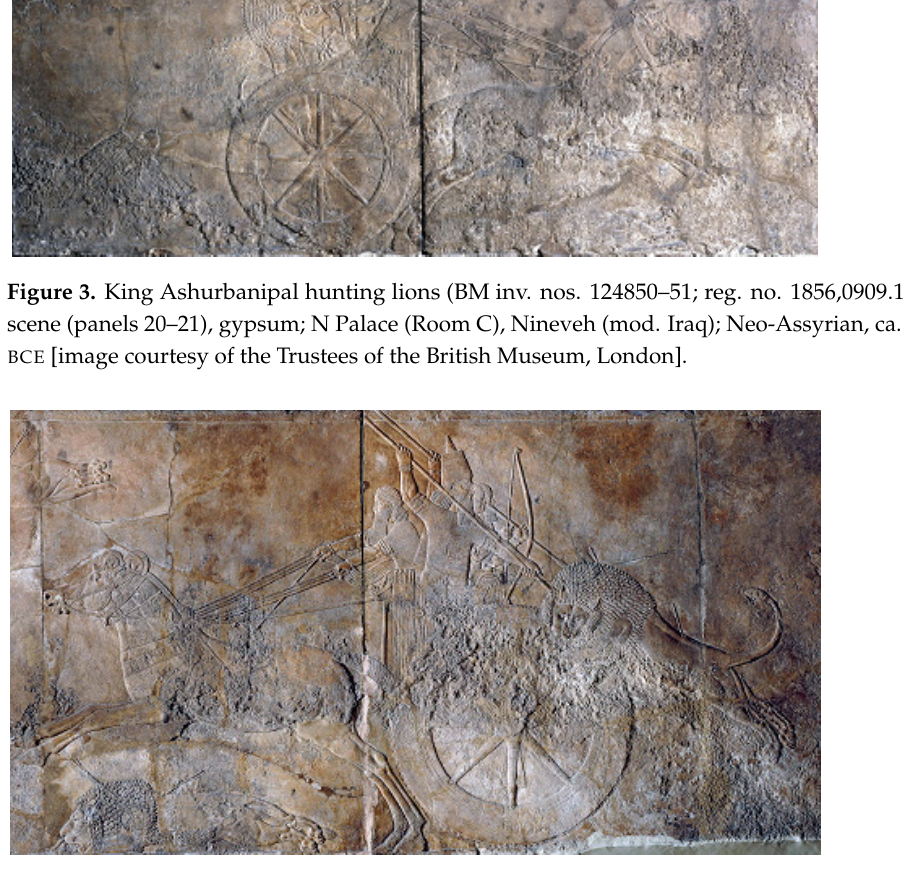
Figure 4. King Ashurbanipal striking lion (BM inv. no. 124854) (as preceding).